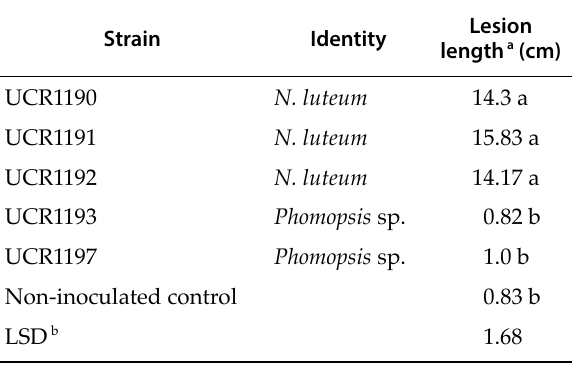
Table 1. Mean lesion lengths induced on shoots by three N. luteum and two Phomopsis sp.